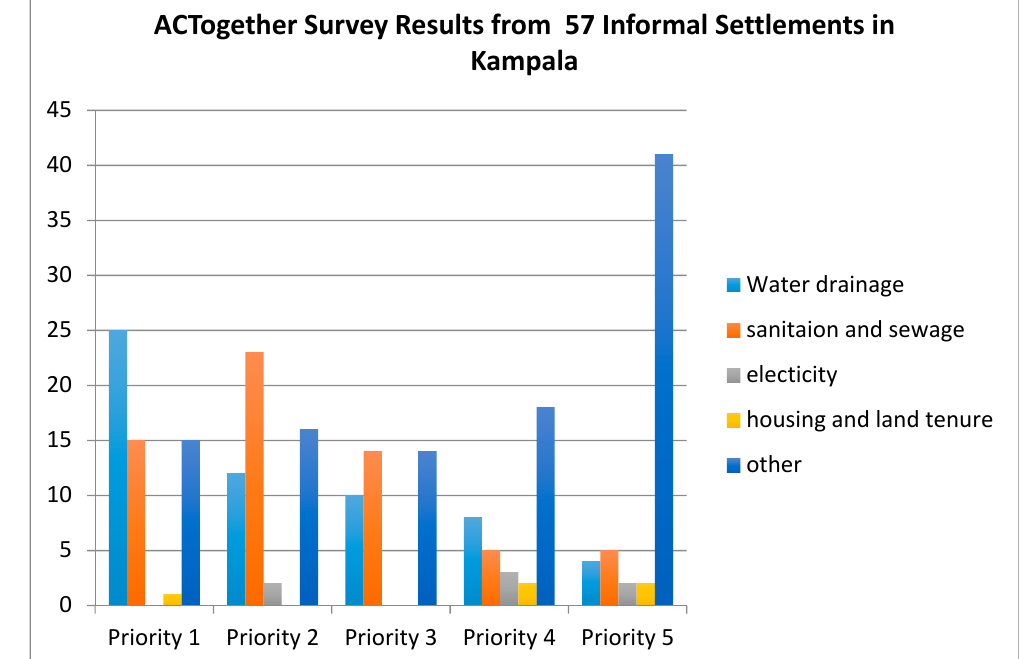
Figure 1. ACTogether Survey Results from 57 Informal Communities in Kampala. Priorities are determined by surveying the community and are ranked from priority 1 to priority 5. The category other includes: garbage collection, school availability, access to health clinics, access to electricity etc.